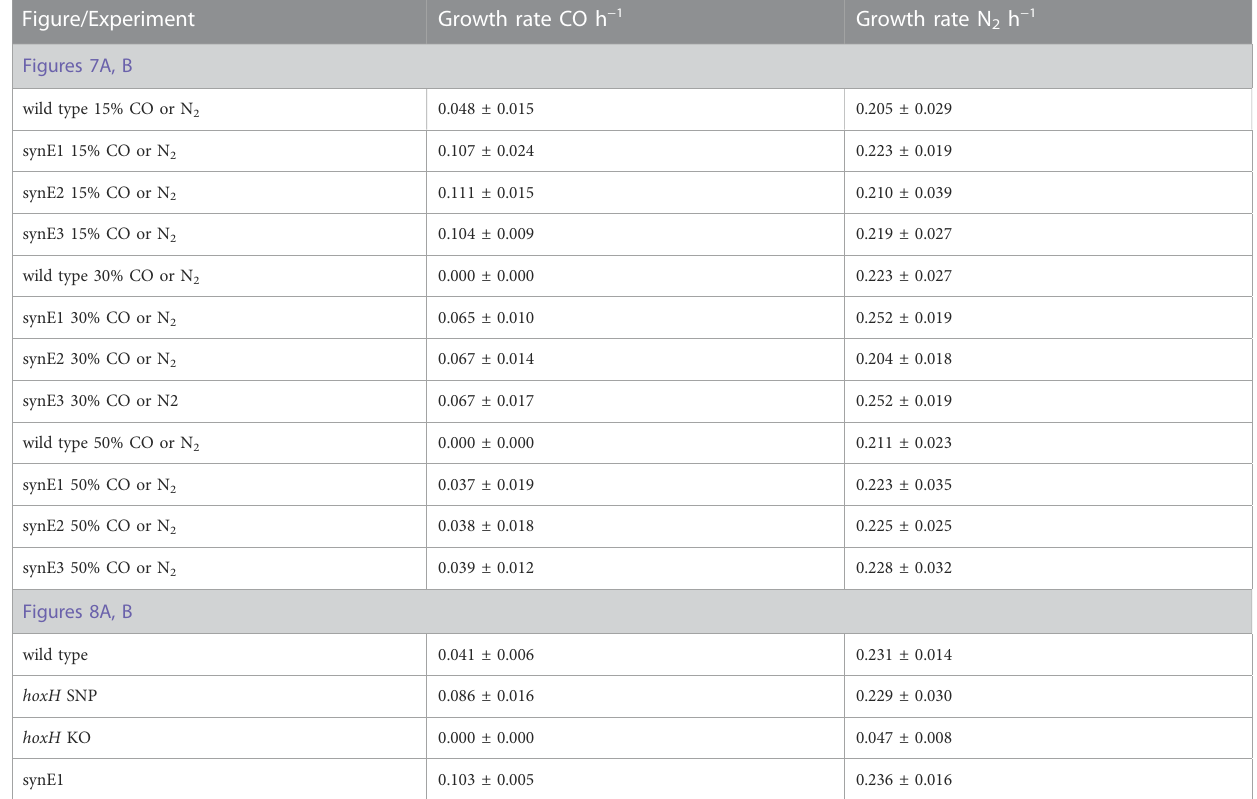
TABLE 6 Autotrophic growth rates for wild type H16, synE1, synE2, synE3, hoxH SNP and hoxH KO strains.